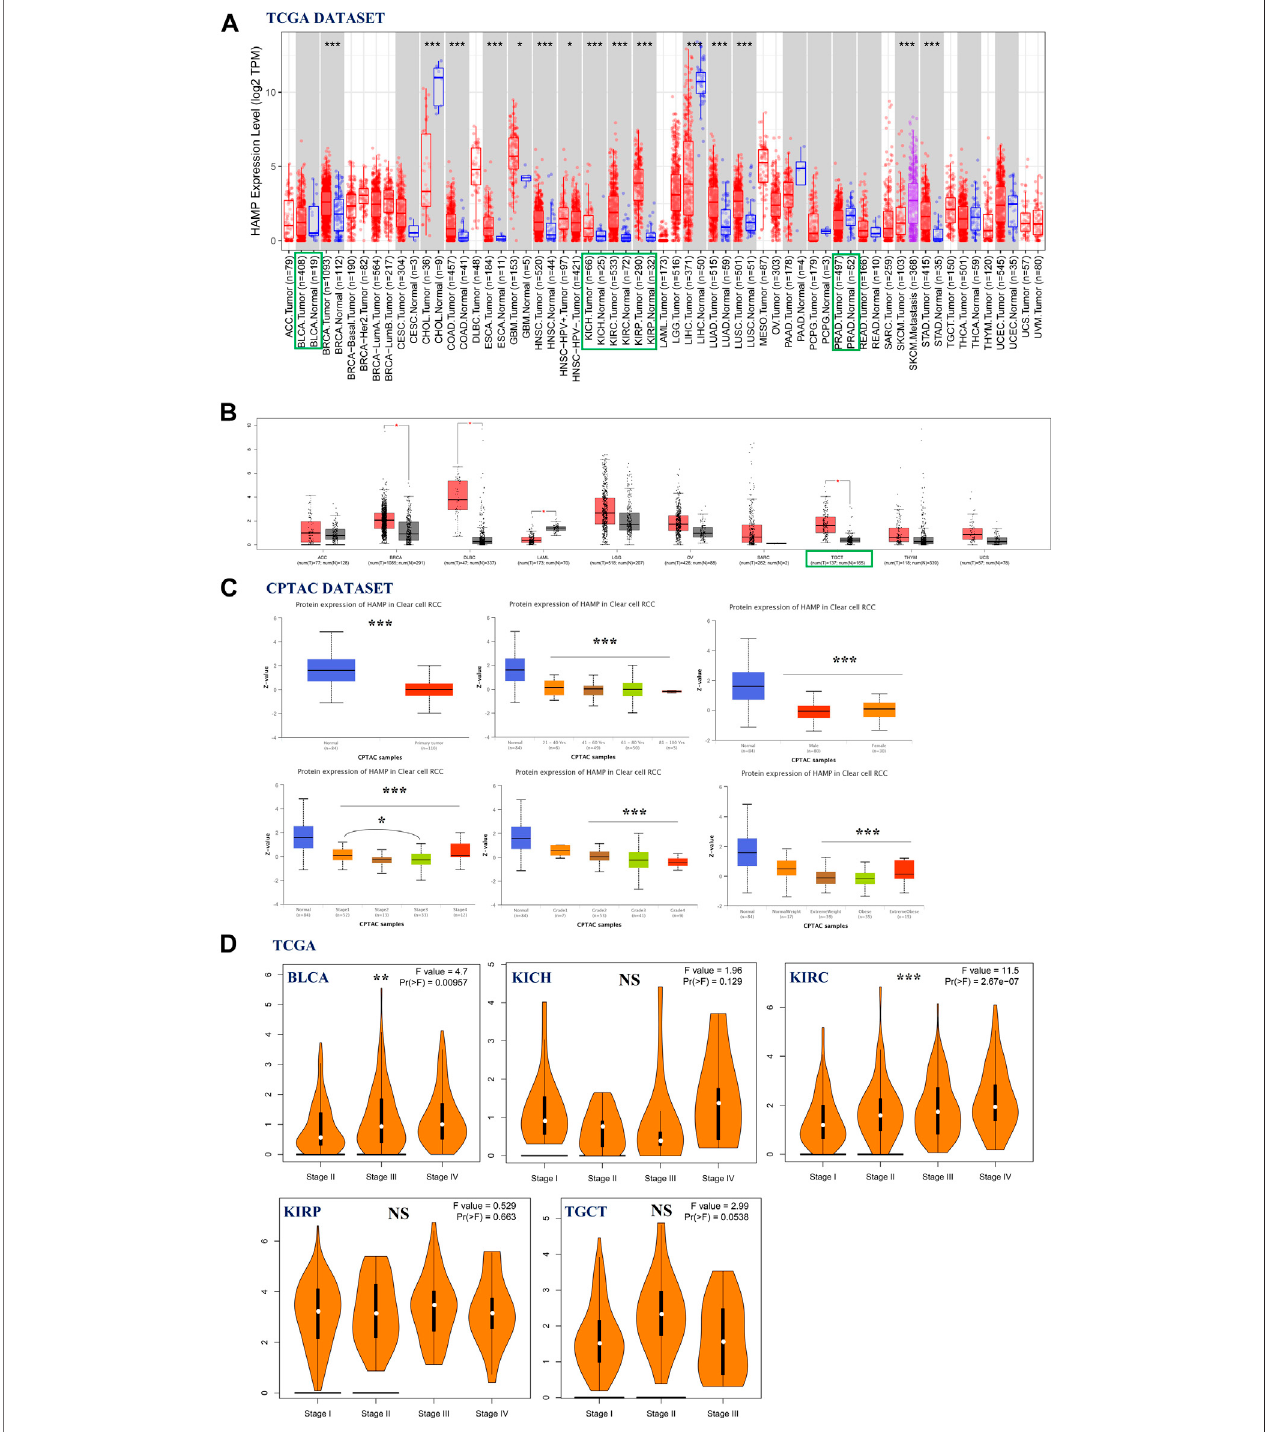
FIGURE 1 | Association of hepcidin levels with clinical parameters in male genitourinary system tumors. (A,B) Hepcidin expression in various types or subtypes of cancers and normal tissues as analyzed by TIMER2 and GEPIA2. (C) Protein levels of hepcidin in kidney renal clear cell carcinoma (KIRC) tissue and normal tissue combining various clinical parameters as analyzed by CPTAC. (D) Using The Cancer Genome Atlas (TCGA) data; hepcidin expression in different pathological stages of several male genitourinary system tumors. * p < 0.05; ** p < 0.01; *** p < 0.001].